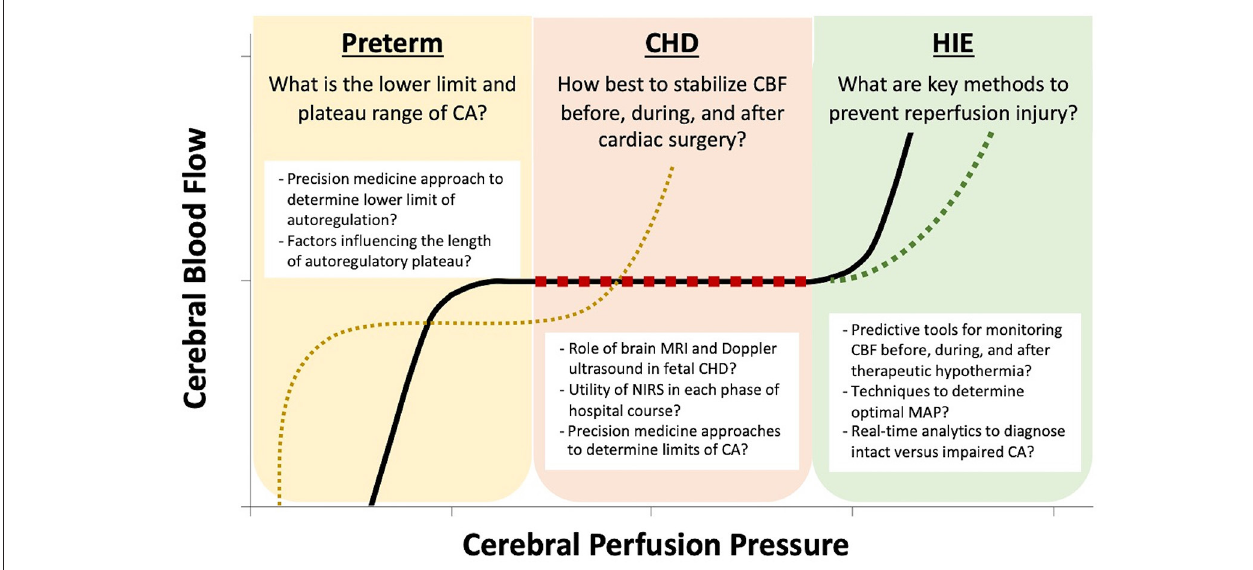
FIGURE 1 | The key questions regarding cerebral autoregulation (CA) are unique to each neonatal pathophysiology. In the preterm neonate, due to immature mechanisms of cerebrovascular adaptation, there is a limited plateau of stable cerebral blood flow (CBF) and there is no strong evidence to guide the optimal lower limit of cerebral perfusion pressure (CPP) by gestational age. In the neonate with congenital heart disease (CHD), postnatal hypoxia and stabilization of CBF before, during, and after cardiac surgery are the prominent challenges. For neonates with hypoxic ischemic encephalopathy (HIE), avoidance of reperfusion injury plays a key role in limiting neurologic